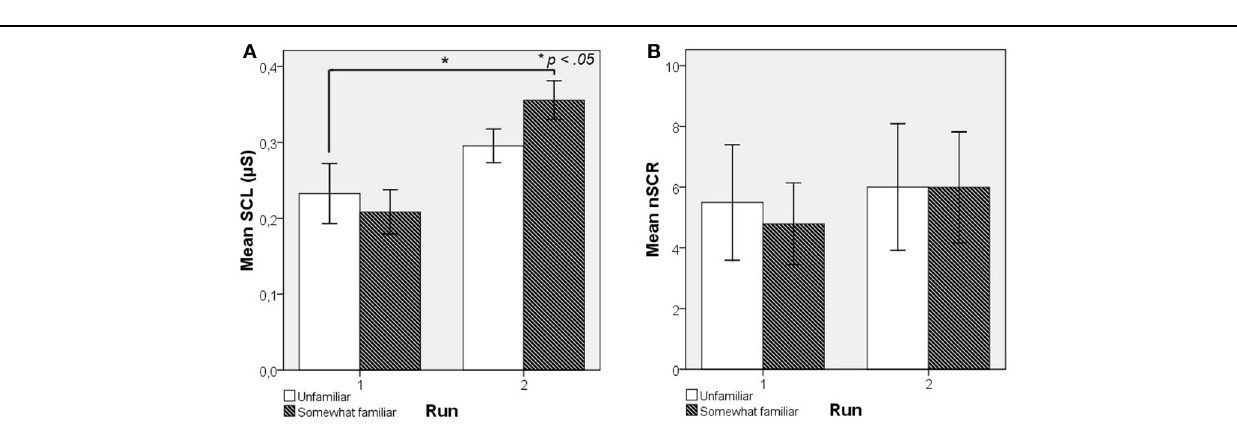
FIGURE 4 | Mean skin conductance level values as a function of self-rated familiarity from Experiment 2: SCL values (A) and mean nSCR values (B) grouped by